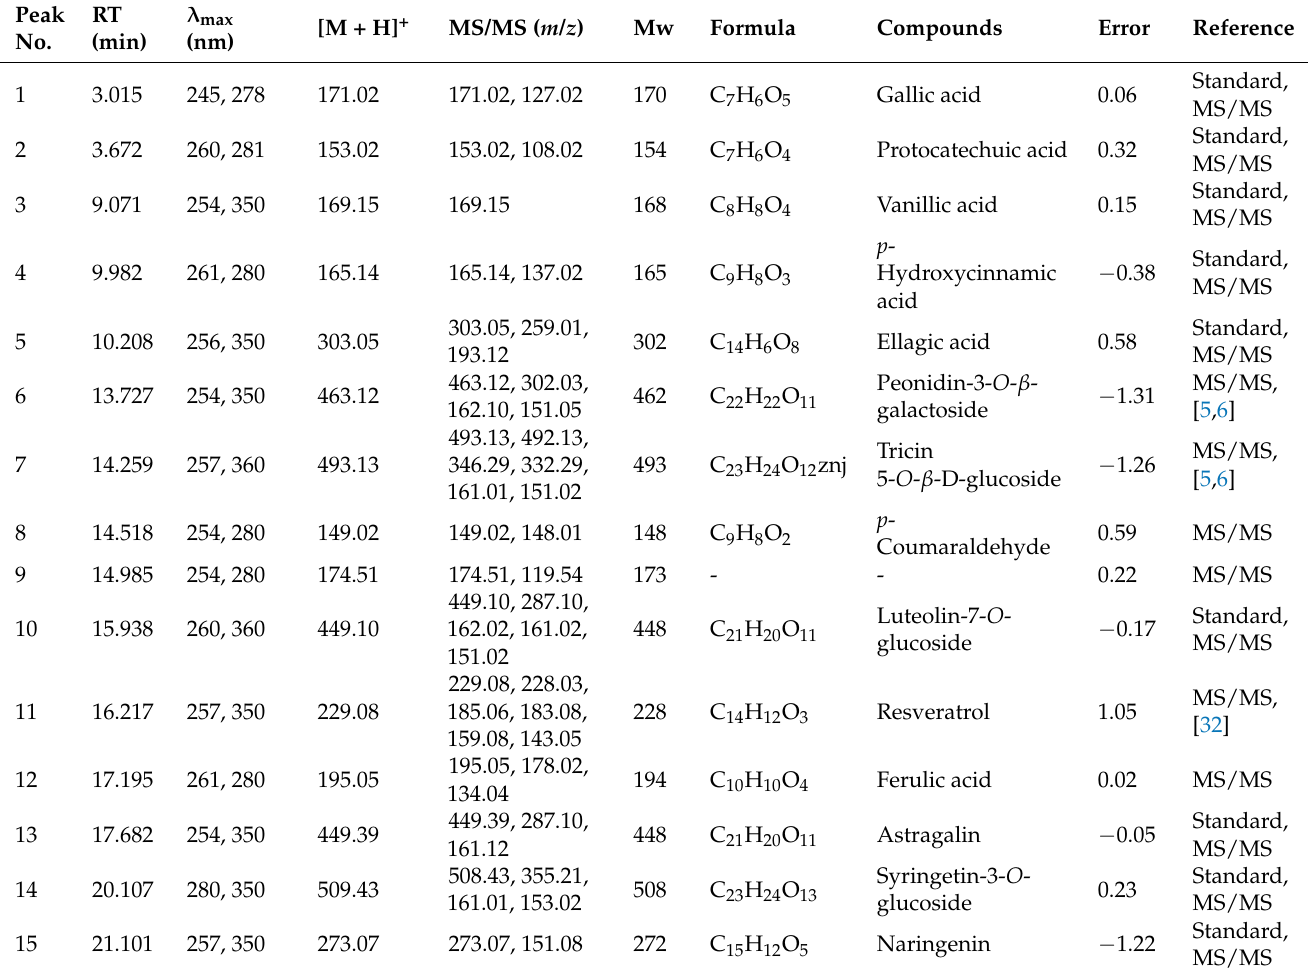
Table 2. Identification of free and bound phenolic fractions in RTF by HPLC-ESI-qTOF-MS/MS.